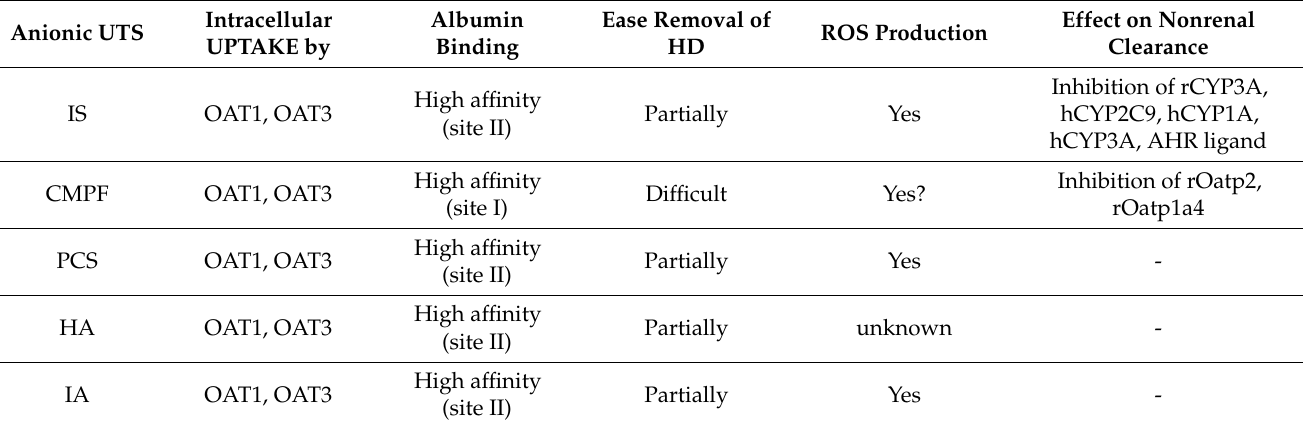
Table 4. Pharmacokinetics and redox properties of anionic